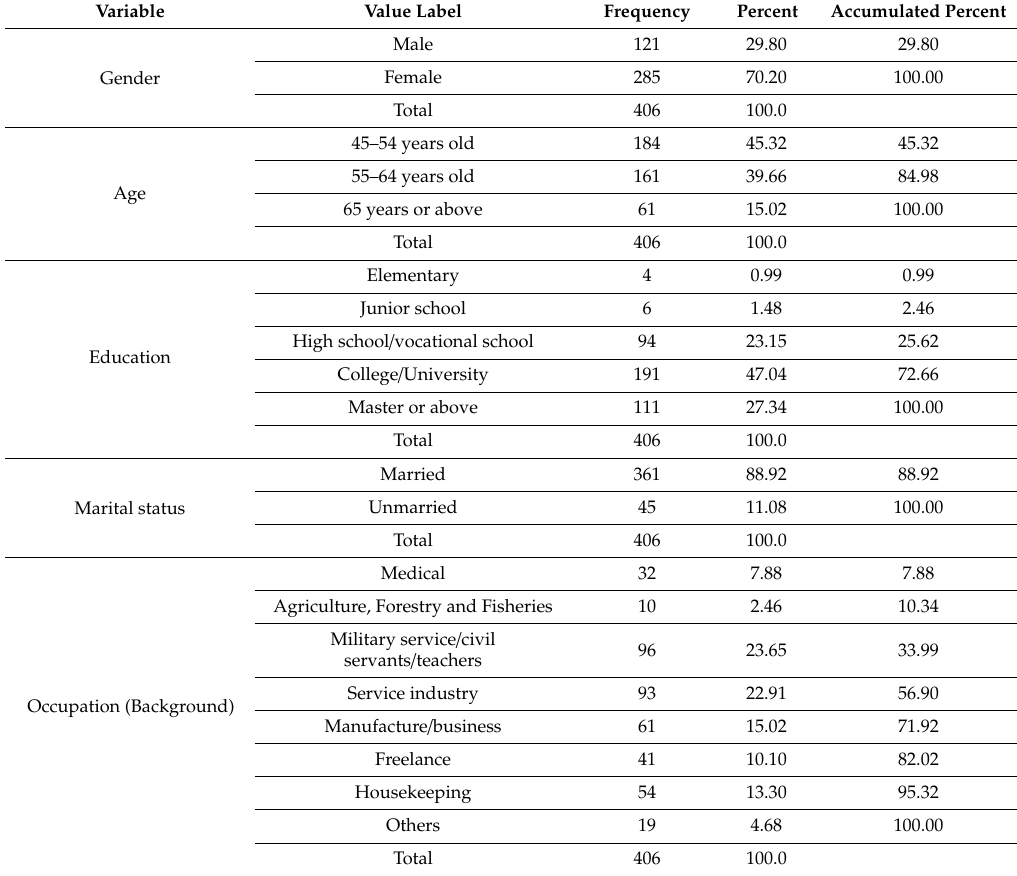
Table 1. Frequency distribution